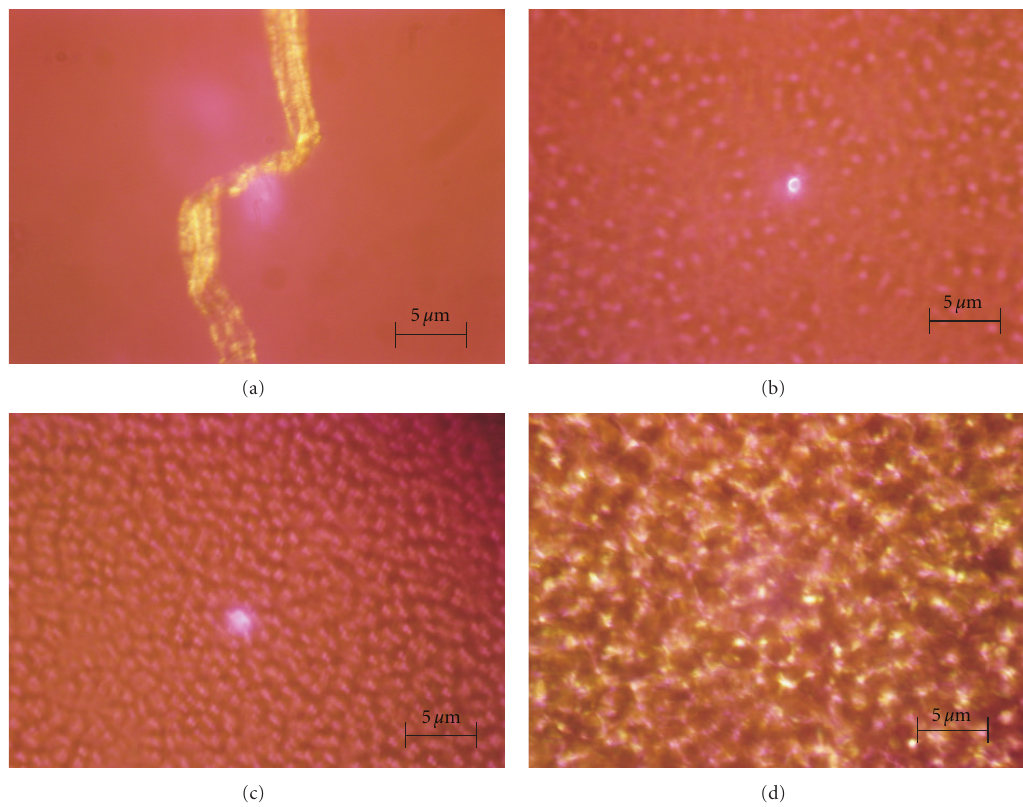
Figure 1: Morphology of the CTA-nitromethane system with a polymer concentration of 8 wt% at temperatures of 55 ◦ (a), 50 ◦ (b), (c), and 25 ◦ C (d) after thermostatting for 30 min (a), (b), 1h (c), and 2h (d). The microphotos were made in polarized light.